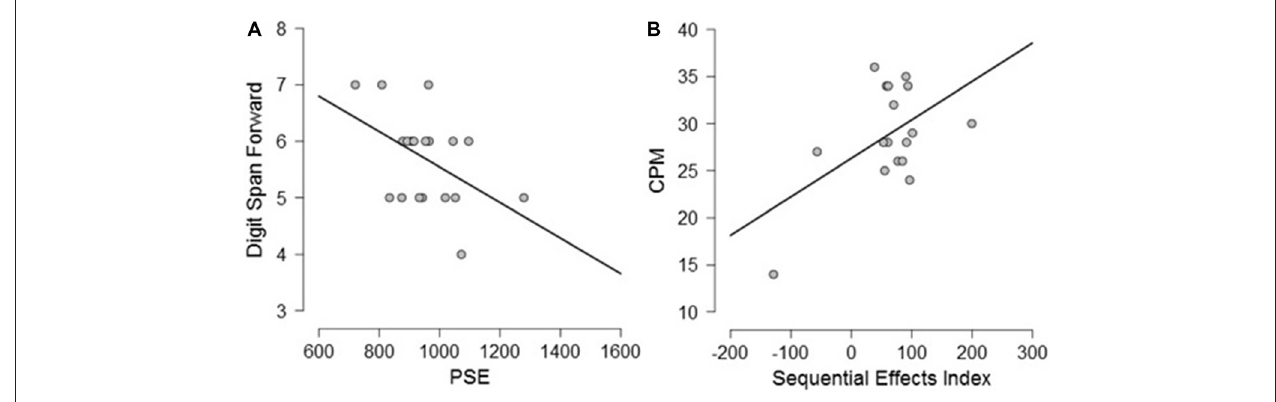
FIGURE 7 | Graphical representation of the correlational analyses conducted between (A) PSE and Digit Span forwards and (B) between Sequential Effects Index and Color Progressive Matrix (CPM) in PD